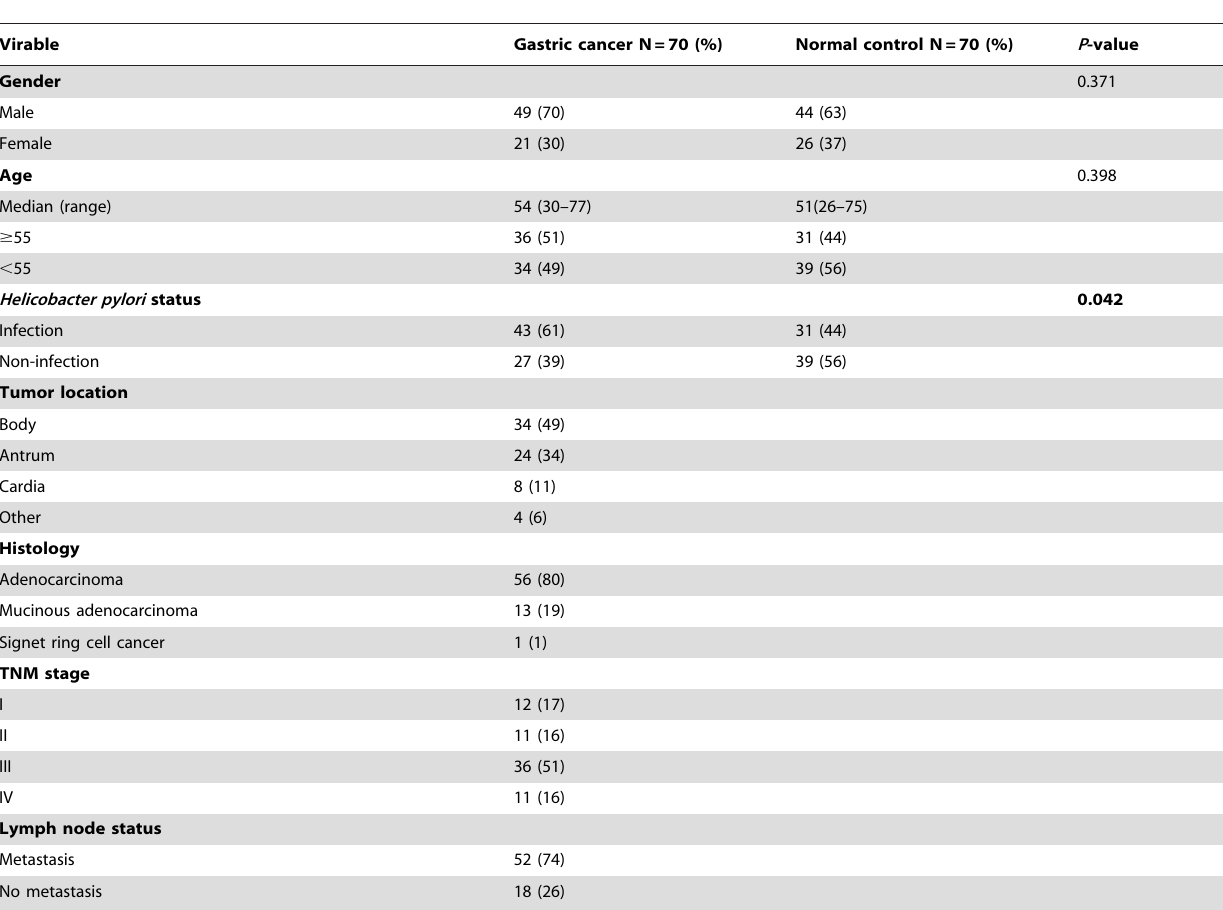
Table 1. Clinical feature of the gastric cancer (GC) patients and healthy control subjects in the training set and the validation